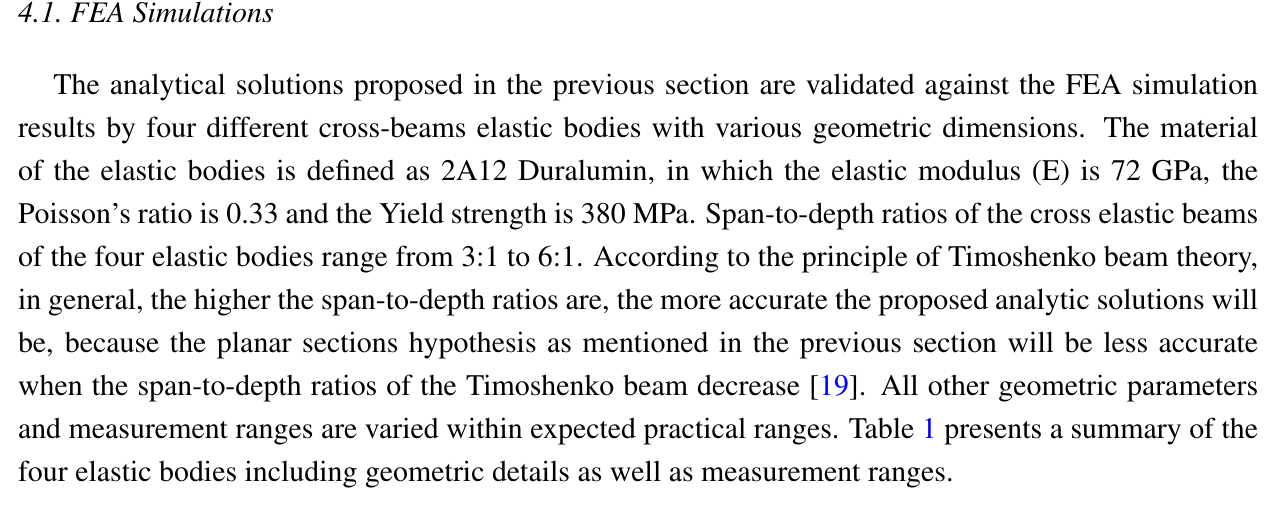
Table 1. Summary of four elastic bodies for